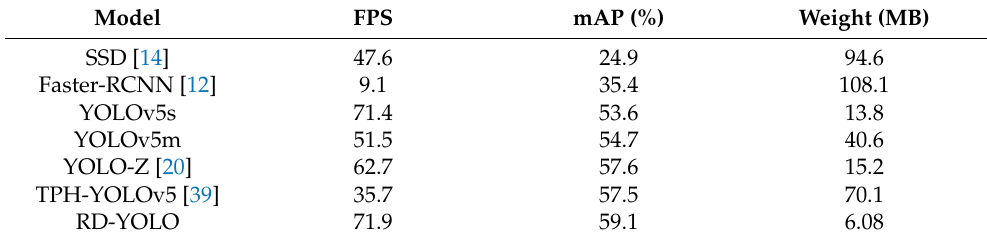
Table 5. Performance comparison of different algorithms on the Rope3D dataset.